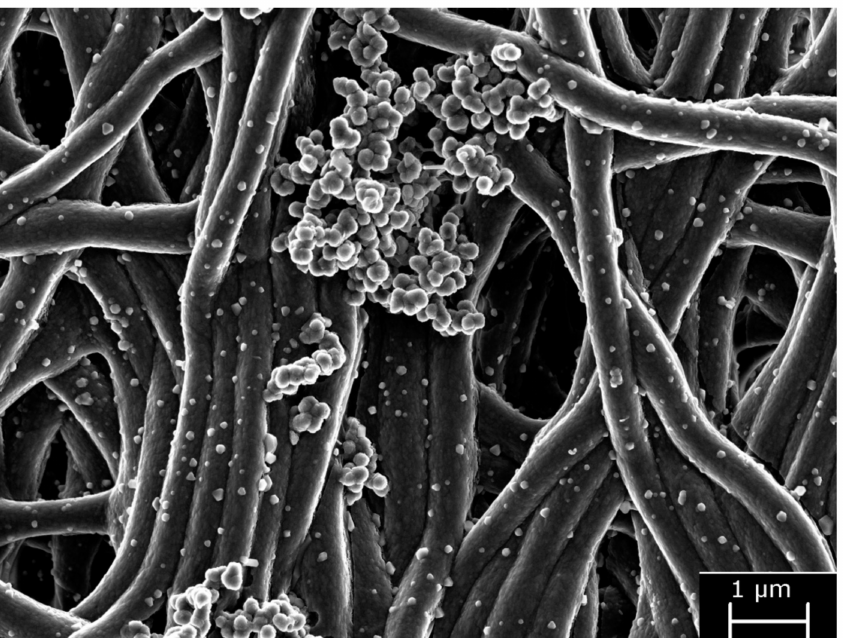
Figure 4. FESEM micrographs of a Zn-doped membrane after immersion in SBFS. Nanofiber diameter is about 500 nm, and fibers lost the smooth appearance of their surface. Nanodeposits of mineral (100 nm) are randomly distributed onto the nanofiber surfaces. Numerous agglomerations of other spherical nanocrystals (bigger than 200 nm) are identified onto the Zn-matrix